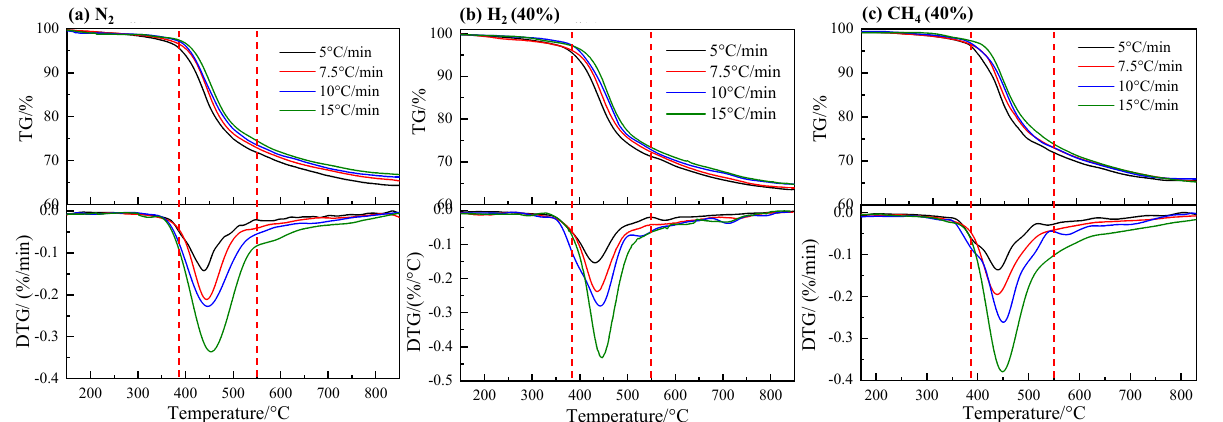
Figure 5. TG − DTG curves of coal pyrolysis: ( a ) N 2 atmosphere; ( b ) H 2 (40%) atmosphere and; ( c ) CH 4 (40%) atmosphere. Table 3. Pyrolysis characteristic parameters of coal samples at different heating rates.